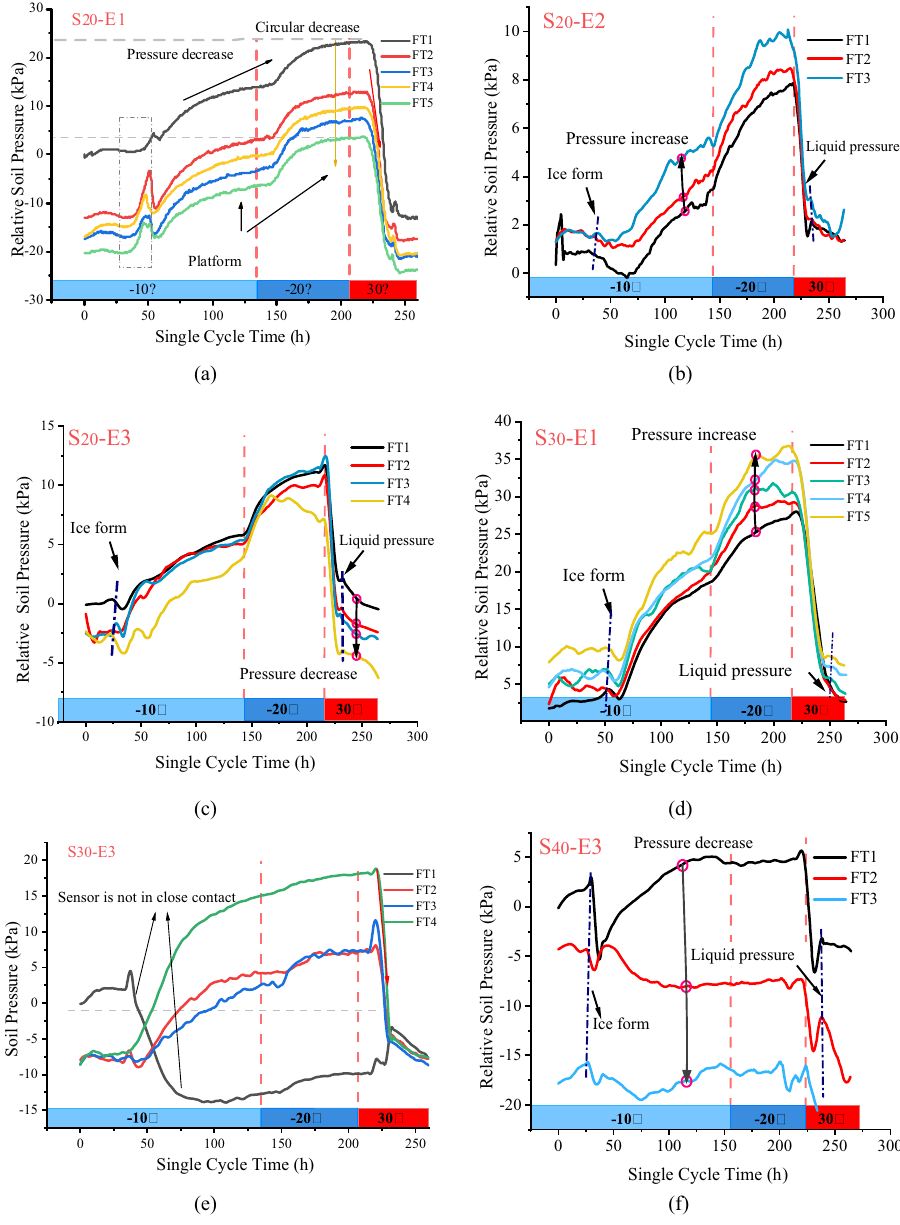
Figure 4. Relative soil pressure in the slope during multiple freeze–thaw cycles (( a ) bottom of the S 20 slope; ( b ) middle of the S 20 slope; ( c ) top of the S 20 slope ( d ) bottom of the S 30 slope ( e ) top of the S 30 slope; ( f ) top of the S 40